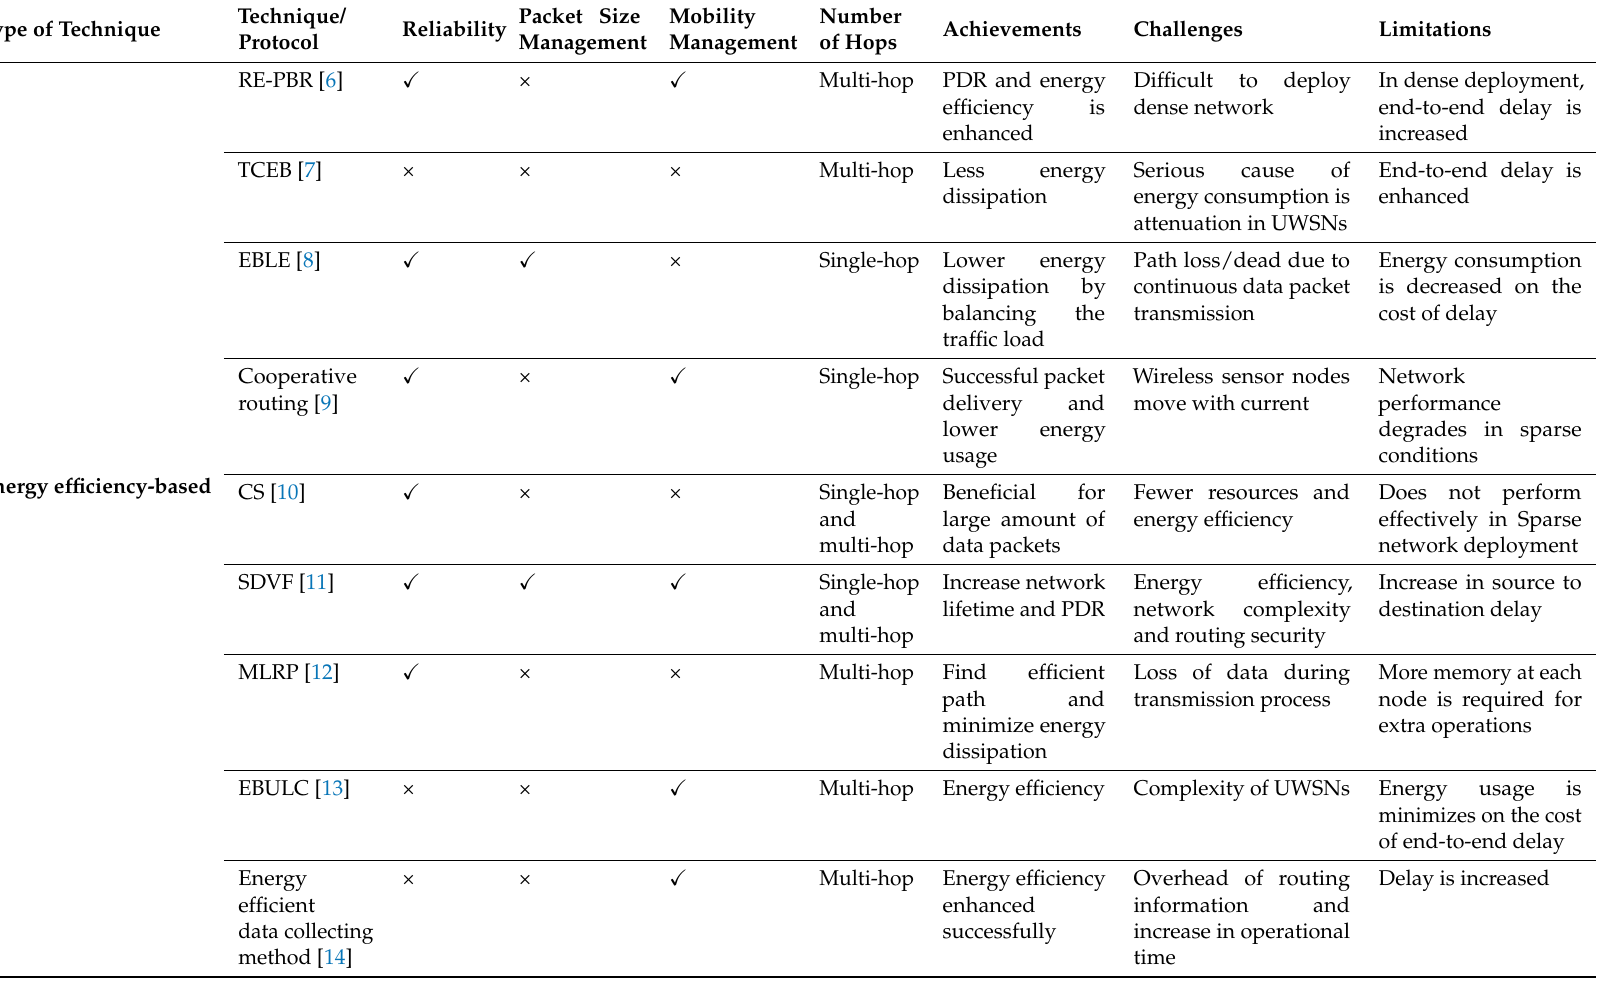
Table 2. Comparison of different